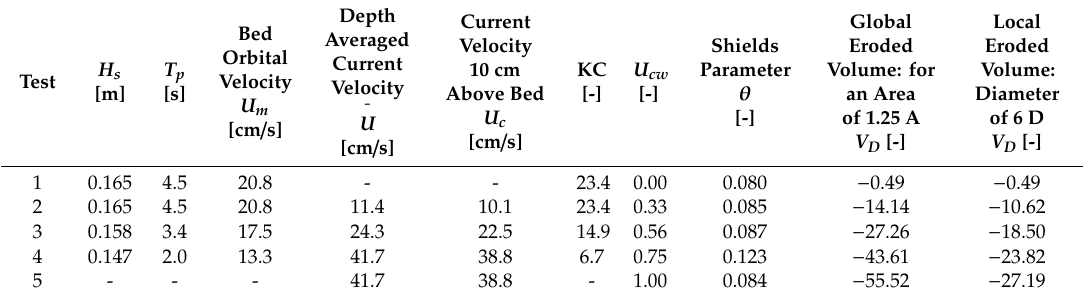
Table 1. Test conditions / Measured values (waves are propagating in 90 ◦ to the current).